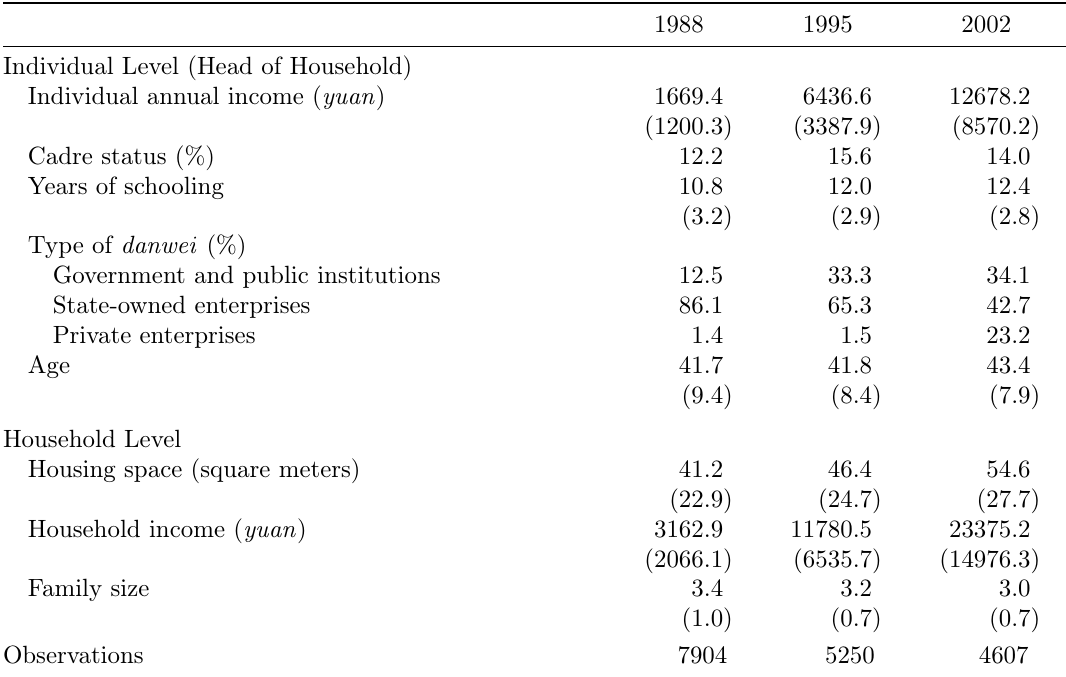
Table 1: Descriptive Statistics by